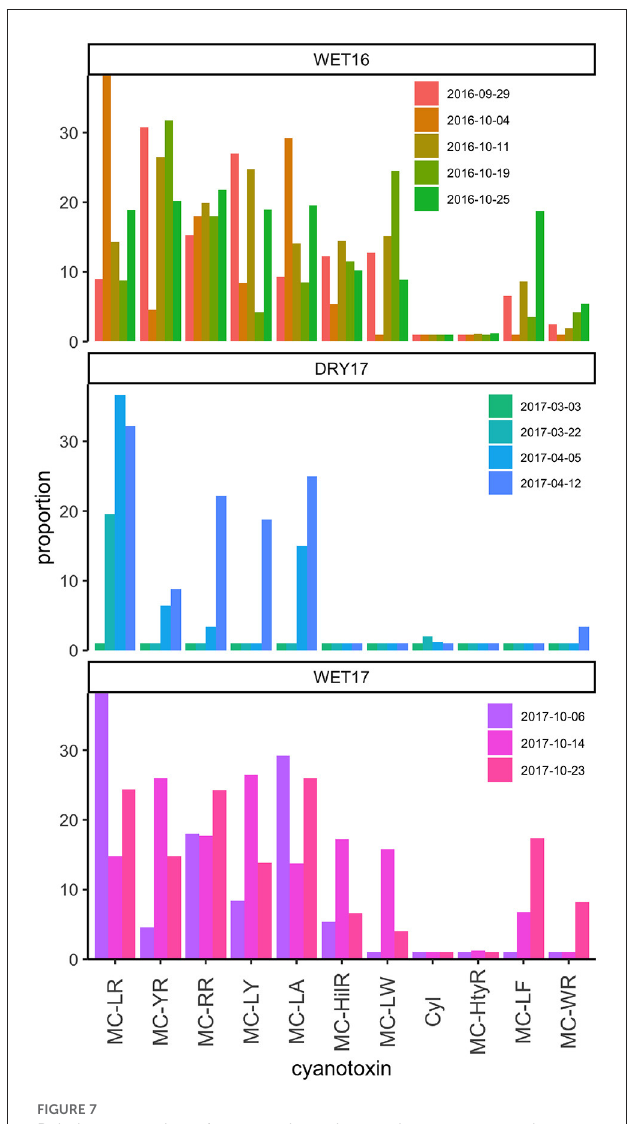
FIGURE7 Relative proportion of cyanotoxins, microcystin congeners and cylindrospermopsin, during experiments. Microcystins are represented by congener designation MC-[variable amino acid position 2], MC-[variable amino acid position 4]. Changes in side groups are also denoted by position through standard chemical nomenclature. CYN denotes